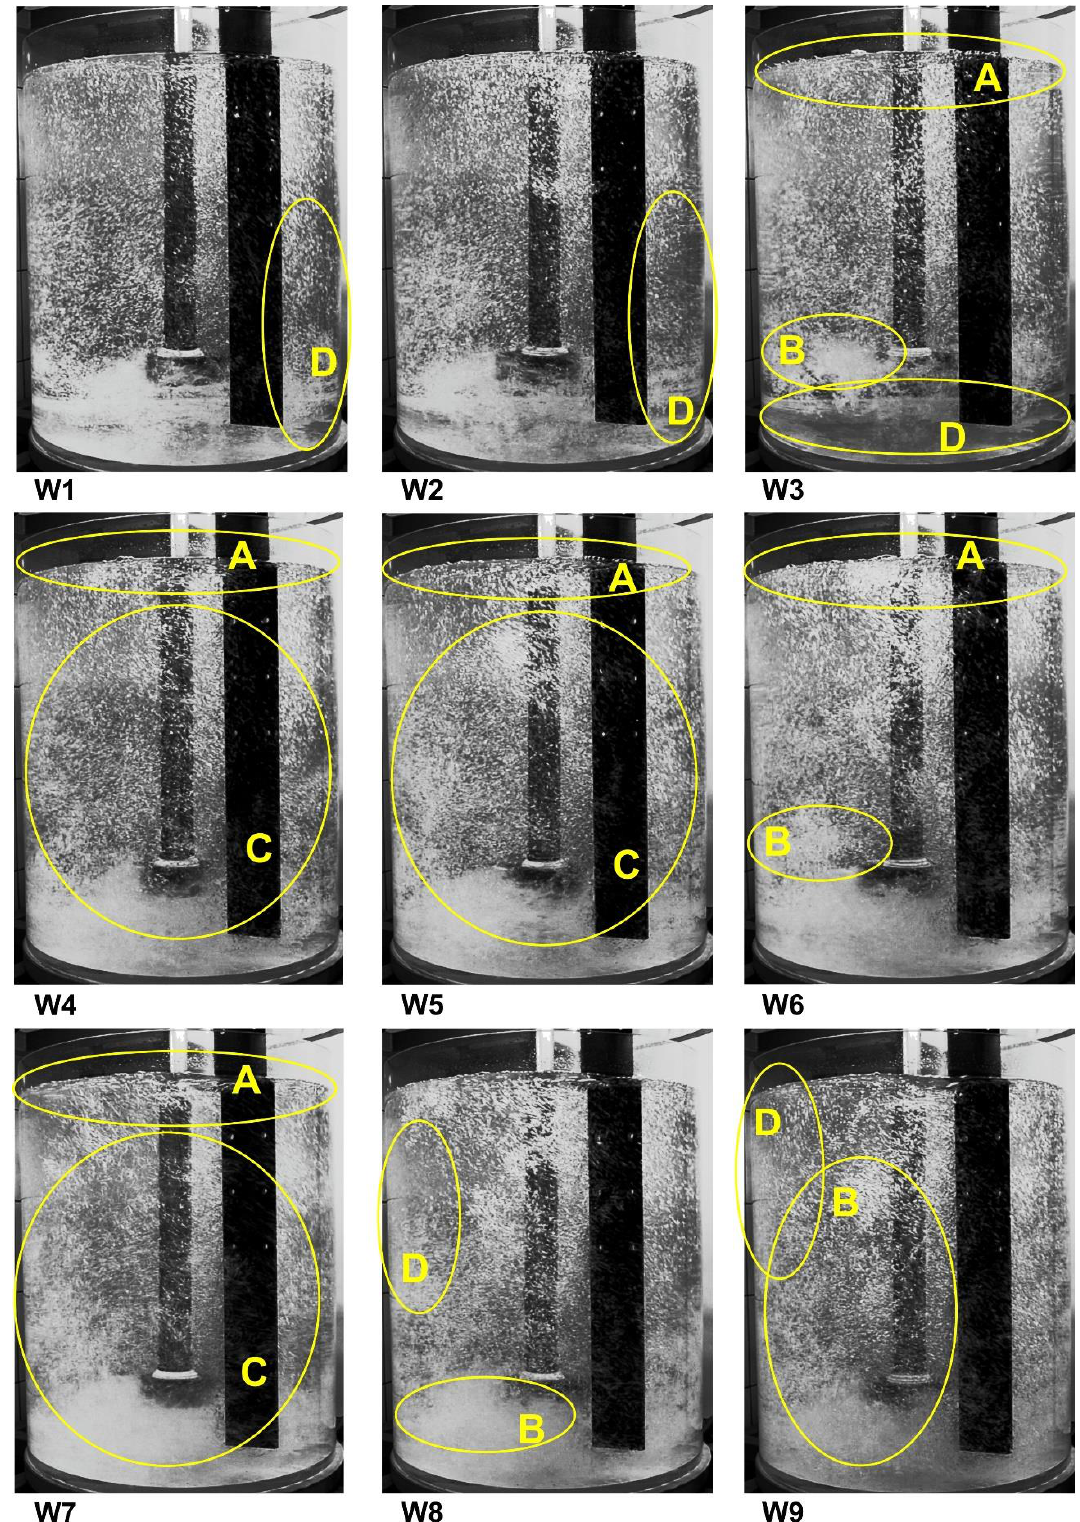
Figure 4. Gas bubbles ’ dispersion registered for different processing parameters, A — single gas bubbles formed on the surface of the modeling liquid, B — excessive formation of gas chains and swirls, C — uniform distribution of gas bubbles in the entire volume of the tank, D — dead zones without gas bubbles, no dispersion.